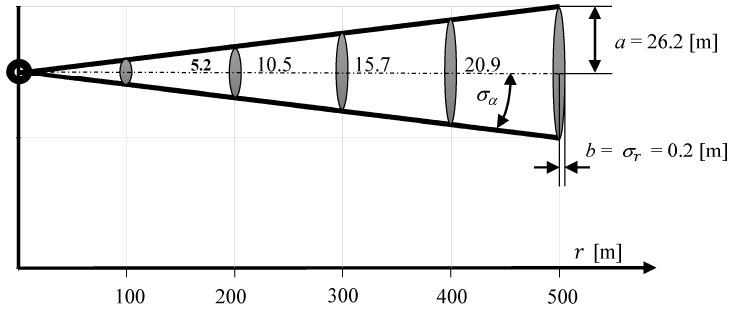
Figure 4. Changing the parameters of the mean error ellipse as a function of measured distance.